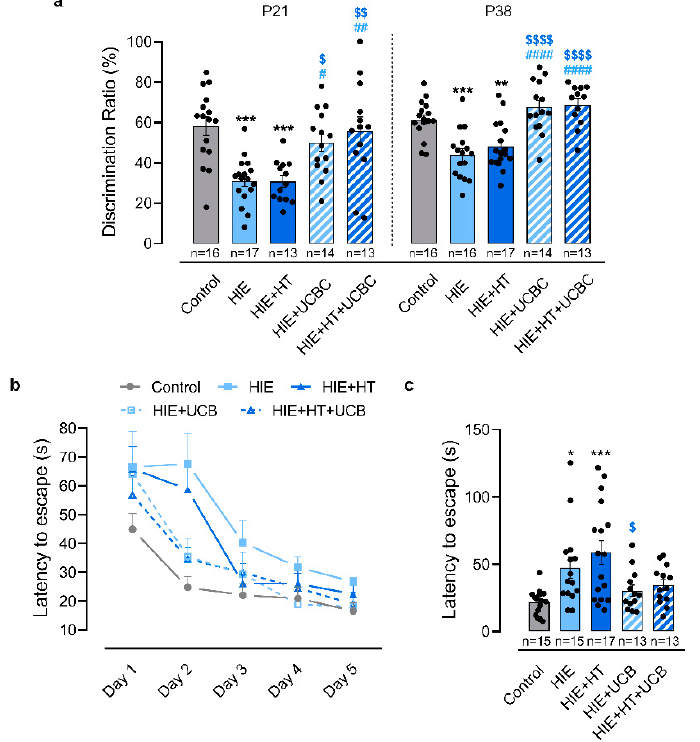
Figure 4. Intravenous administration of UCBC improved cognitive deficits after neonatal HI injury at different developmental stages. ( a ) Discrimination ratio, i.e., percentage of time spent exploring the novel object, in the novel object recognition test at P21 and P38. Latency, in seconds, to find the escape hole during the Barnes maze test throughout the five days of testing ( b ) and on the second day ( c ). Data are presented as mean ± SEM of 12 to 17 animals per group in the novel object recognition test (Table S14); and 13 to 17 animals per group in the Barnes maze test (Table S15). Statistical analysis was performed using one-way ANOVA coupled with Tukey’s multiple comparison test (* p < 0.05, ** p < 0.01, and *** p < 0.001 compared to the control; # p < 0.05, ## p < 0.01, and #### p < 0.0001 compared to HIE; $ p < 0.05, $$ p < 0.01, and $$$$ p < 0.0001 compared to HIE + TH; Table S16).